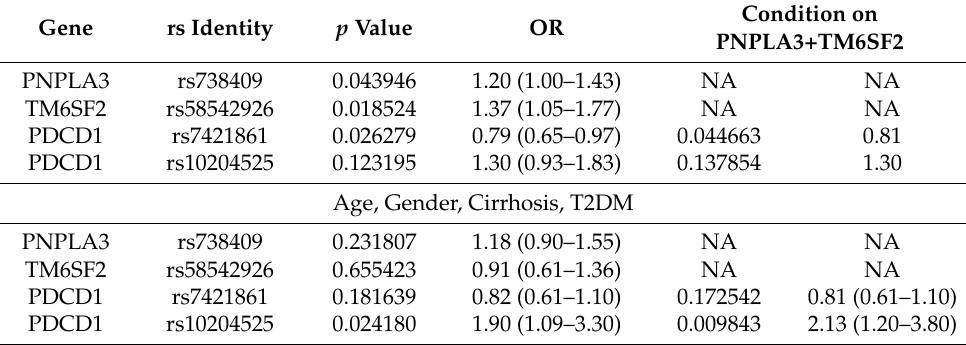
Table 6. META analyses in the combined European